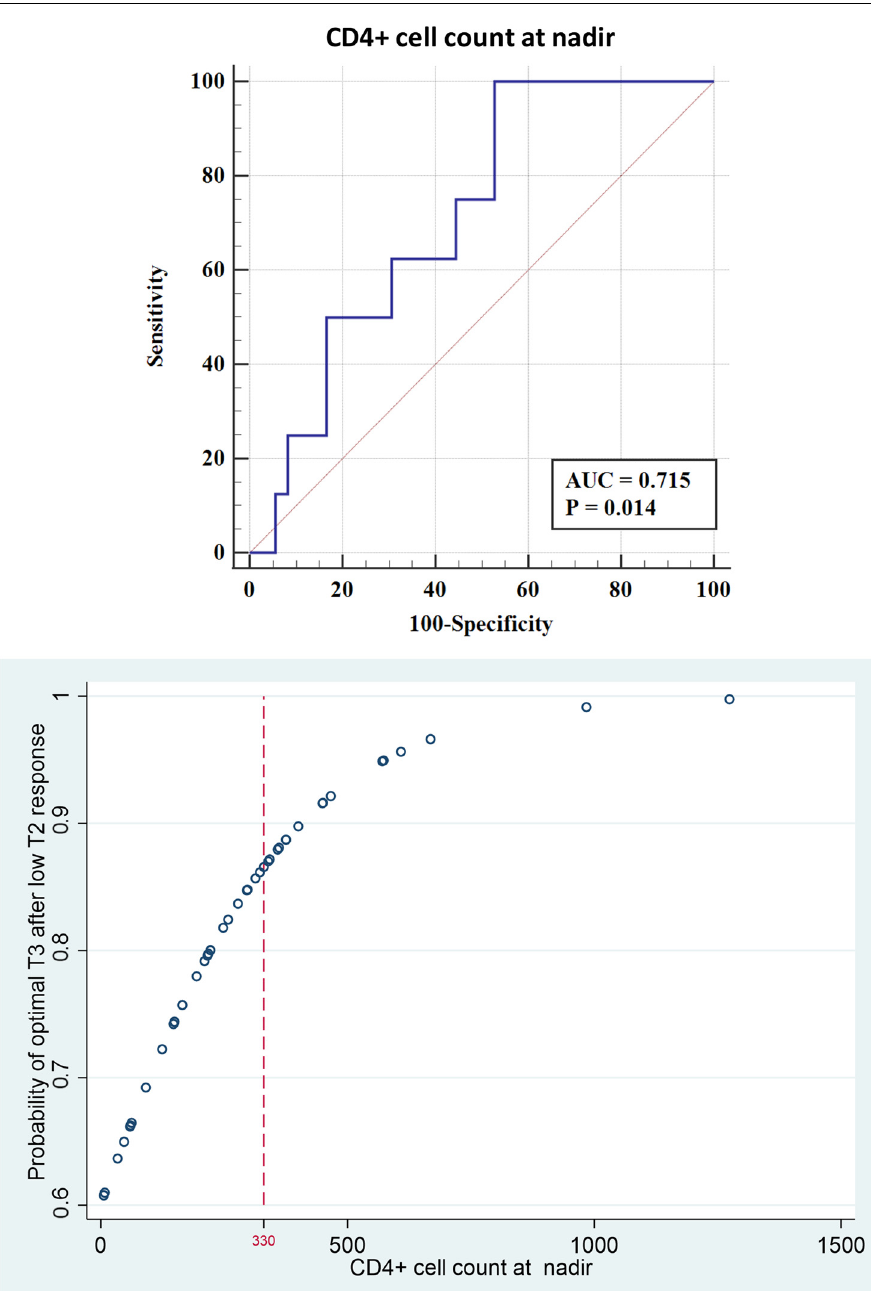
Figure 1. ( Upper ): Receiver operating characteristic curve analysis of the CD4+ count at nadir for low or intermediate IgG response at T3 in patients with low IgG response at T2. ( Lower ): Logistic model prediction of optimal T3 response probability among the same patients. AUC: area under the curve.